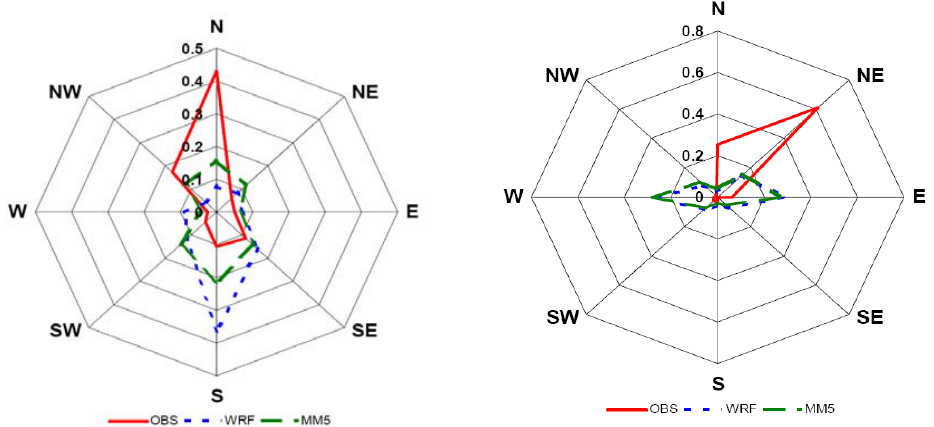
Fig. 2a. Wind roses for Ispra (left) and Mantova (right) monitoring stations, for the whole of the year 2005. The scale indicates the frequency of the wind direction.